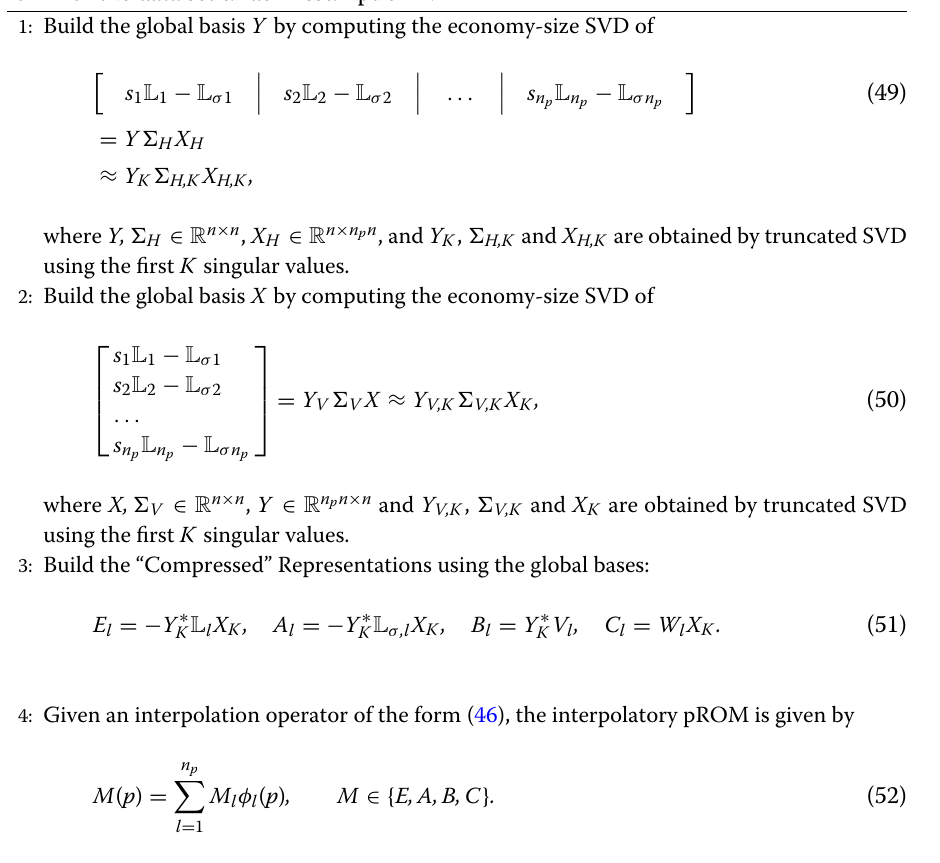
Algorithm 1 Generation of interpolation-oriented Loewner ROMs in the compressed form for the data set under Assumption